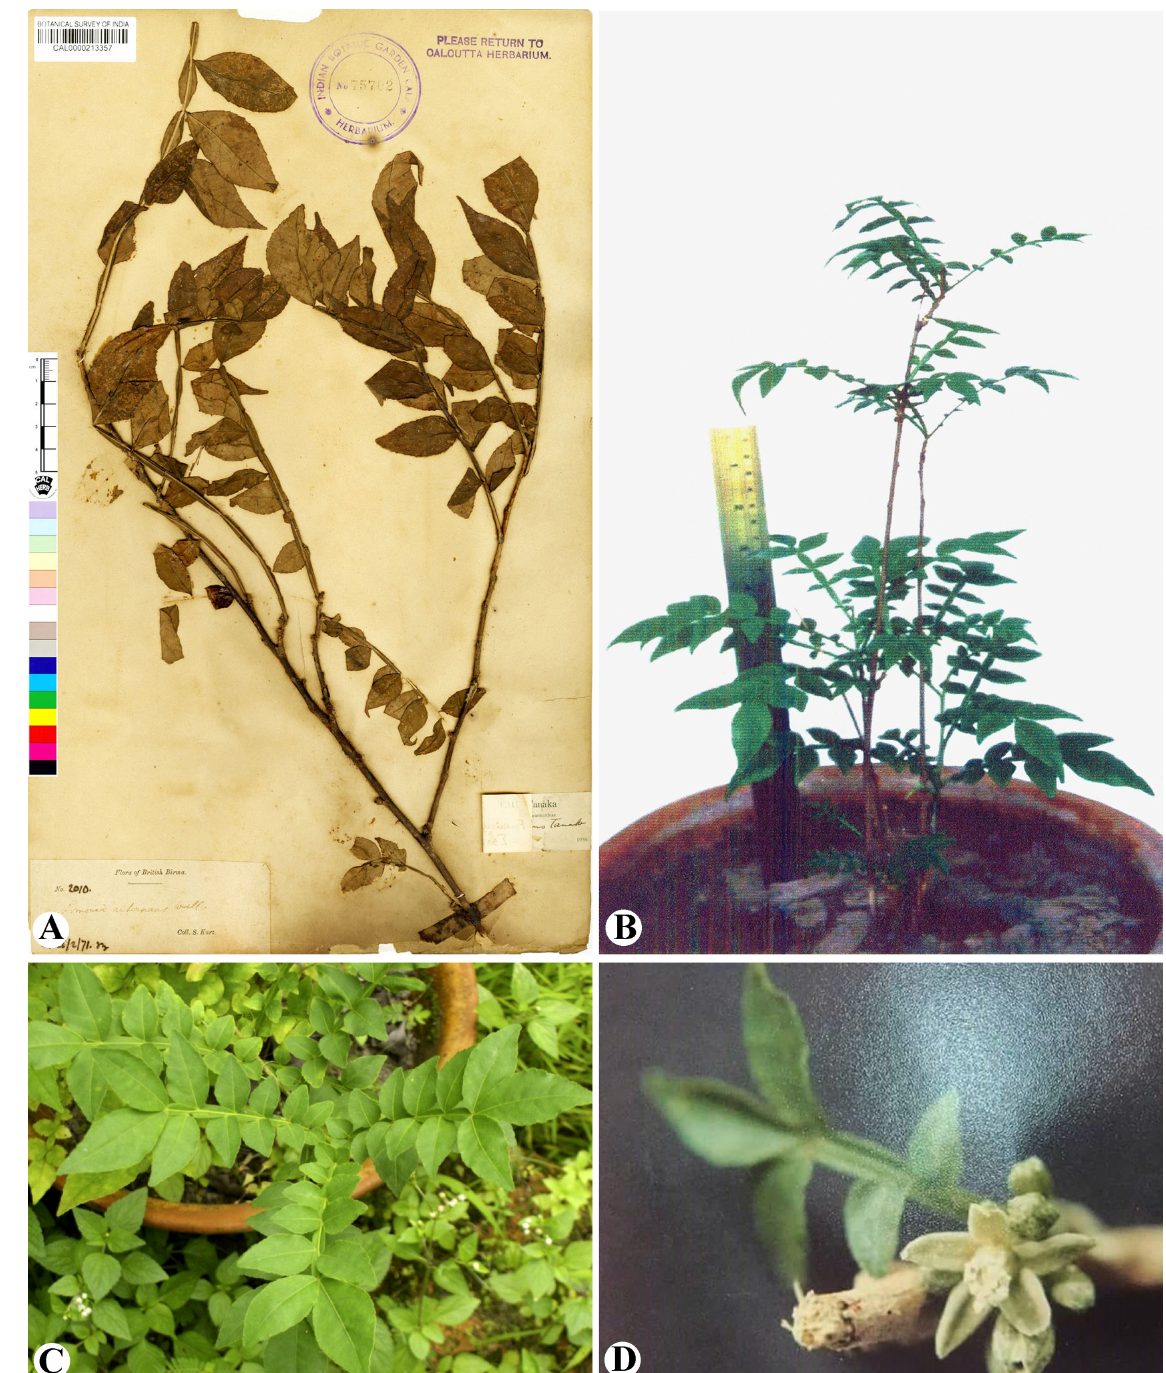
Fig. 3. Bergera alternifolia (Kurz) F.J.Mou comb. nov. A . Holotype, S. Kurz 2010 , CAL0000213357 (Botanical Survey of India, CAL). B. Cultivated plant. C . Leaves of cultivated plant. D . Flowers. Photos taken by Yoshiaki Takaya and Hla Myoe Min in